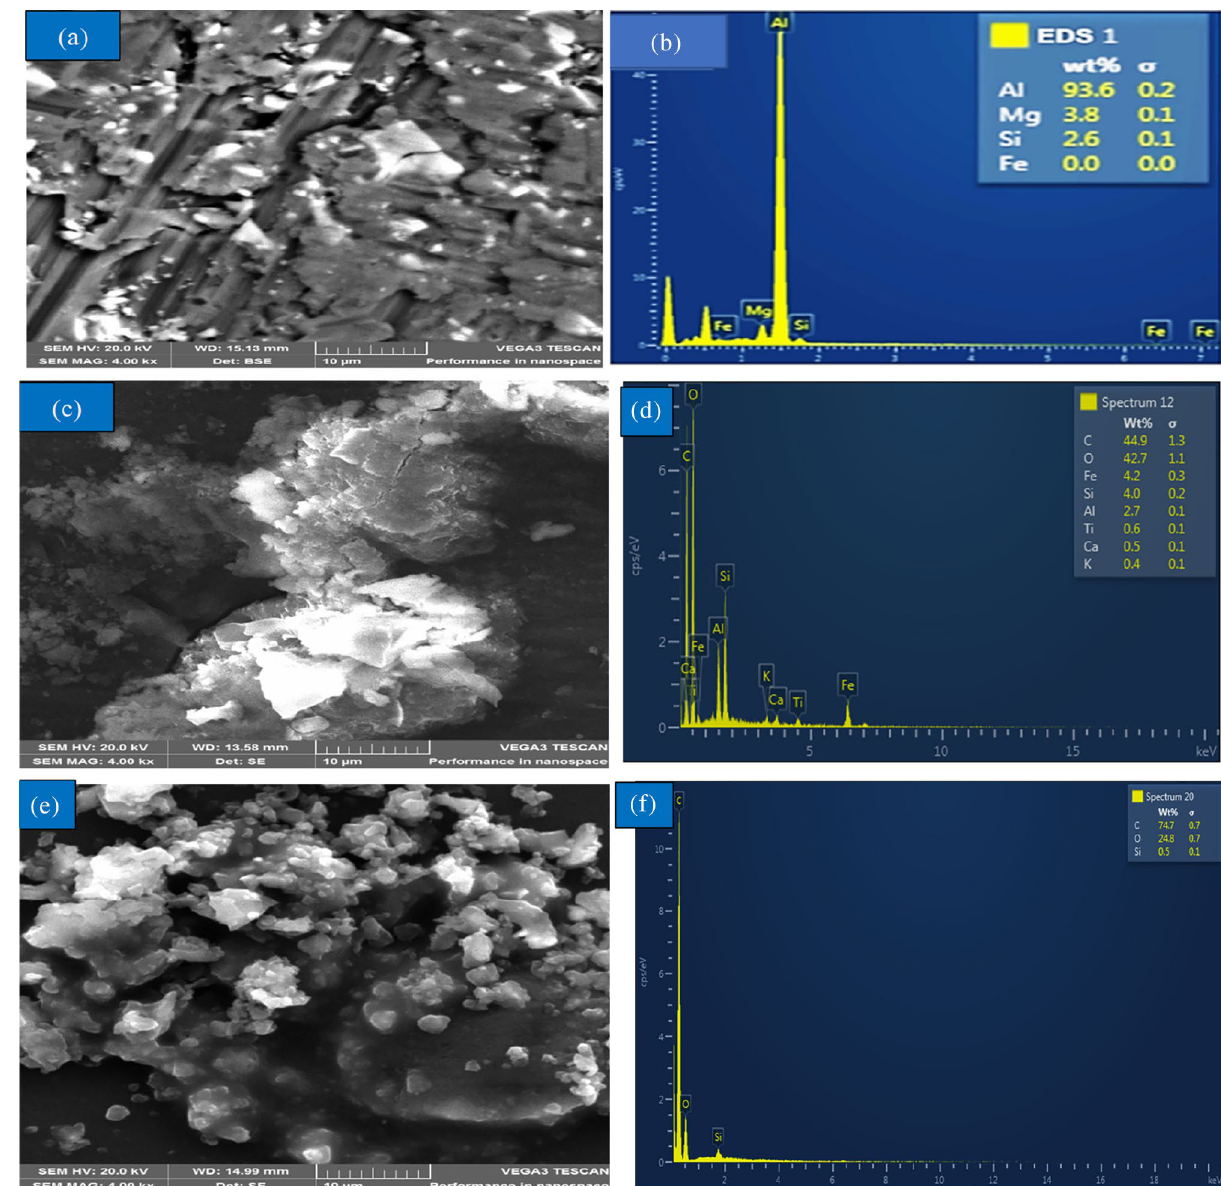
Figure 2. SEM and EDX of Matrix and Reinforcements: ( a ) SEM of Al Alloy, ( b ) EDX of Al Alloy, ( c ) SEM of PP, ( d ) EDX of PP, ( e ) SEM of CCP, ( f ) EDX of